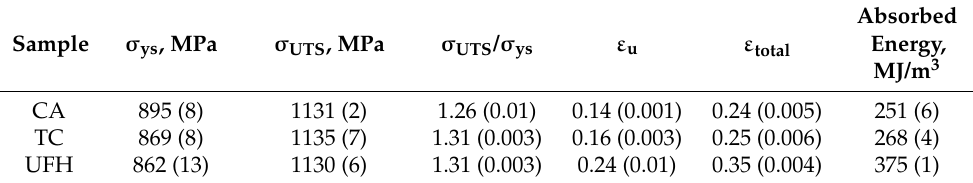
Figure 8. ( a ) Engineering stress-strain curves and ( b ) strain hardening rate v/s true strain curves. Table 3. Mechanical properties (standard deviation).